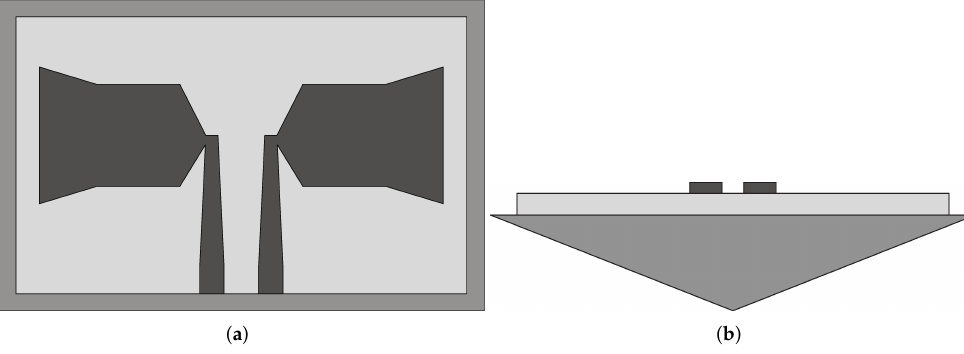
Figure 29. Design layout of the bowtie antenna ( a ) geometry of bowtie ( b ) pyramidal reflector (redrawn from [113]). Dark gray top metal face, medium gray cavity face, and light gray dielec- tric